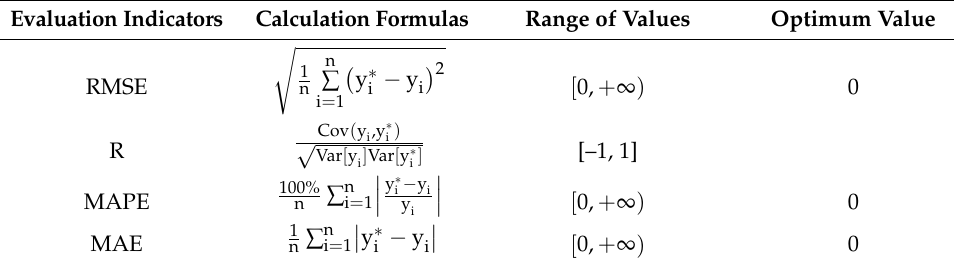
Table 4. Algorithm evaluation